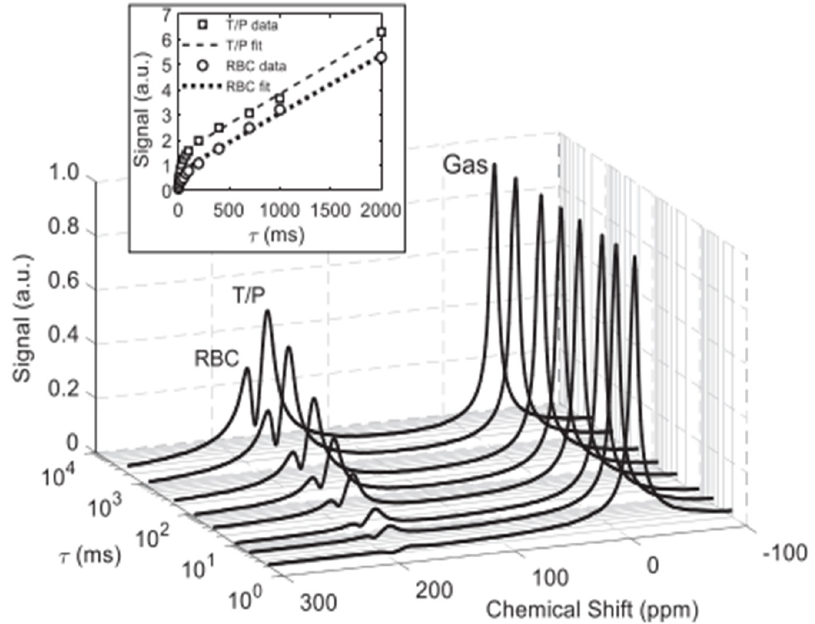
Figure 17. Spectra acquired after varying delay times show the gradual increase in amplitude of both membrane and RBC peaks as alveolar gas diffuses into those compartments and saturates in vascular blood. As seen in the inset, the two processes are well described as an approximately-exponential saturation of pulmonary blood and tissue, followed by an approximately-linear increase as the pulmonary blood is carried back to the heart and beyond.